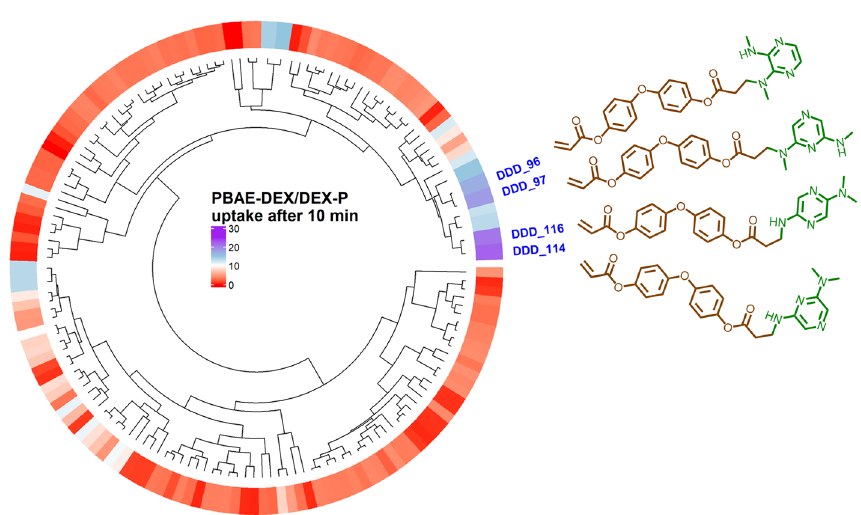
Figure 7. Heatmap of predicted ratio of DEX uptake for PBAE during round2 endcapped with e1 conjugated with DEX over commercial formulation of DEX after 10 min of exposure and structure of PBAE repeated unit with predicted drug uptake superior to best candidate in